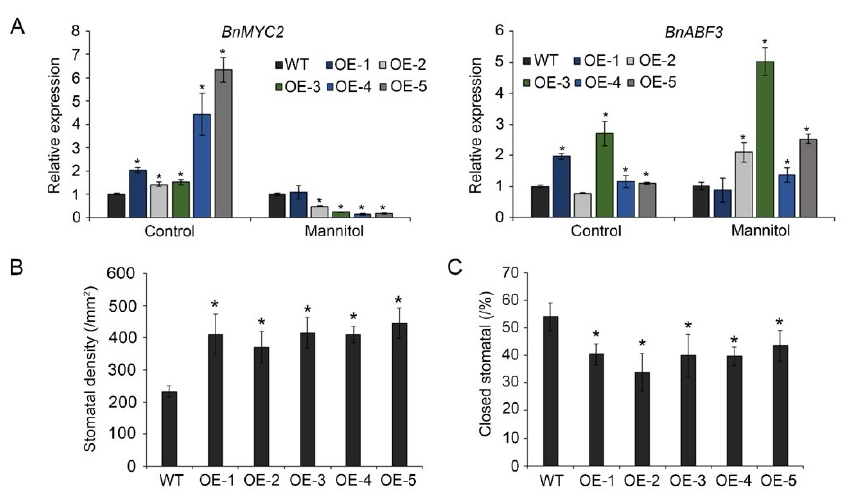
Figure 6. Changes in stomatal density and expression levels of stress-related marker genes. ( A ) Expression patterns of JA- and ABA-responsive genes under 400 mM mannitol stress. Error bars represent standard errors. Asterisks indicate significant differences ( p < 0.05). ( B ) Stomatal density of OE-1, OE-2, OE-3, OE-4, and OE-5 lines. ( C ) Percentage of closed stomata under drought stress. Asterisks indicate significant differences between WT and p35S::BnA.JAZ5 lines ( p < 0.05, Student’s t-test). WT, accession K407; OE-1, OE-2, OE-3, OE-4, OE-5, and p35S::BnA.JAZ5 transgenic lines.